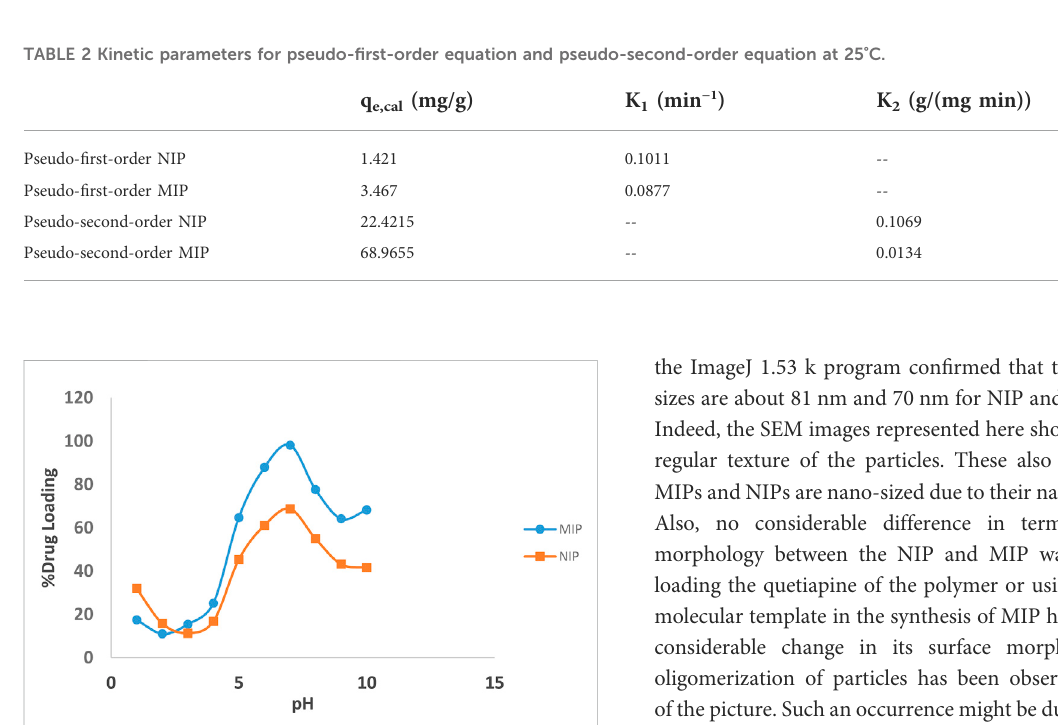
FIGURE 4 Effect of pH on the loading percentages of the drug on the MIP (blue line), and NIP (brown line).